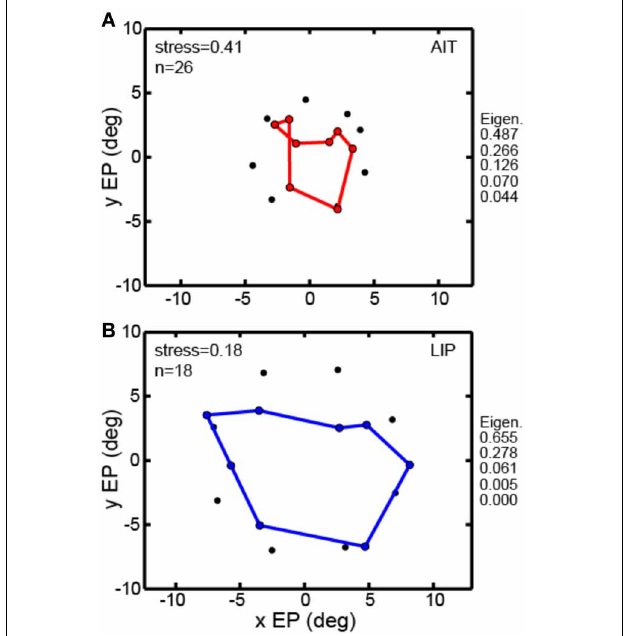
FIGURE 7 | Multidimensional scaling recovery of eye positions from population data using the averaging method with a subset of cells rather than interpolation method employed in Figure 3. (A) Configuration of eye positions recovered from AIT (red points). (B) Configuration of eye positions recovered from LIP (blue points). This averaging method replicates the observation found using the interpolation method; namely, that LIP neurons produce a more accurate representation of eye position than AIT (lower stress in LIP than AIT). Normalized MDS eigenvalues indicated to the right of each